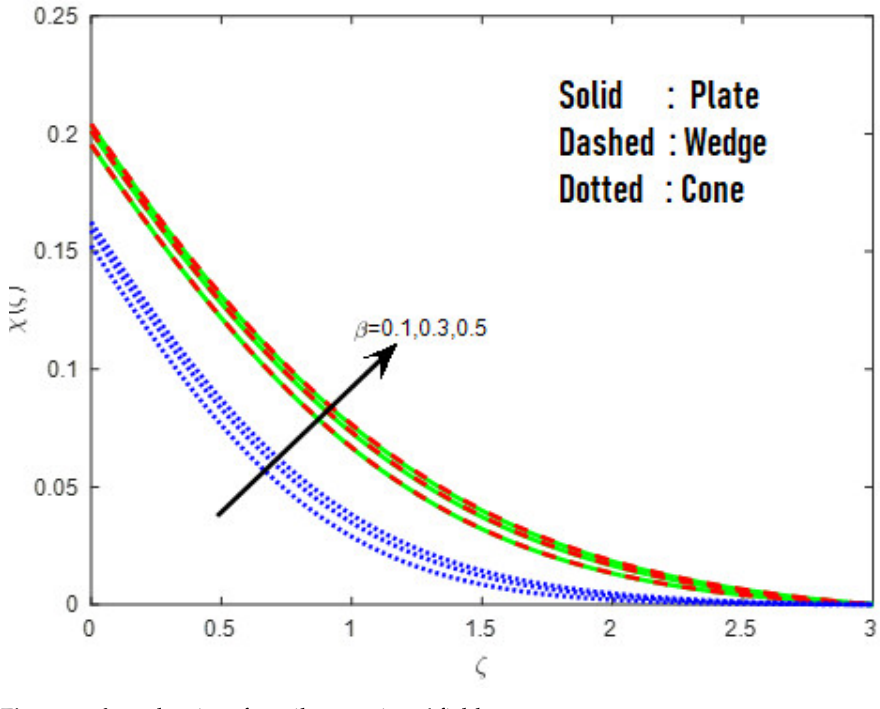
Figure 5. β vs. density of motile organisms’ field. Figure 5.  vs. density of motile organisms’ field. Figure 5.  vs. density of motile organisms’ field.